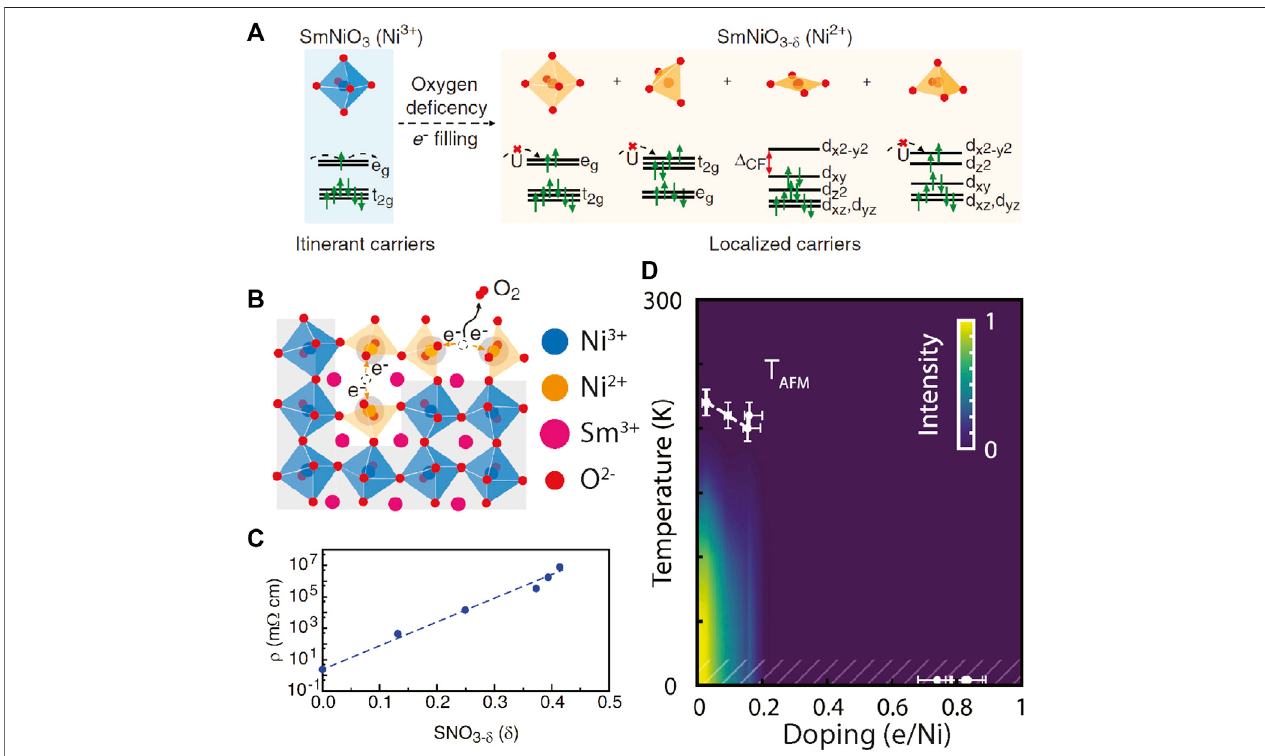
FIGURE2|(A) Illustration ofhow oxygen vacancies modify the localcrystal fi eldsplitting ofNi3d orbitals,together withthe dopingeffect,leadingto opening ofthe bandgap and resistive switching [46]. (B) Oxygen vacancy formation changes the local symmetry from octahedral to lower-than-cubic. (C) Electrical resistivity at